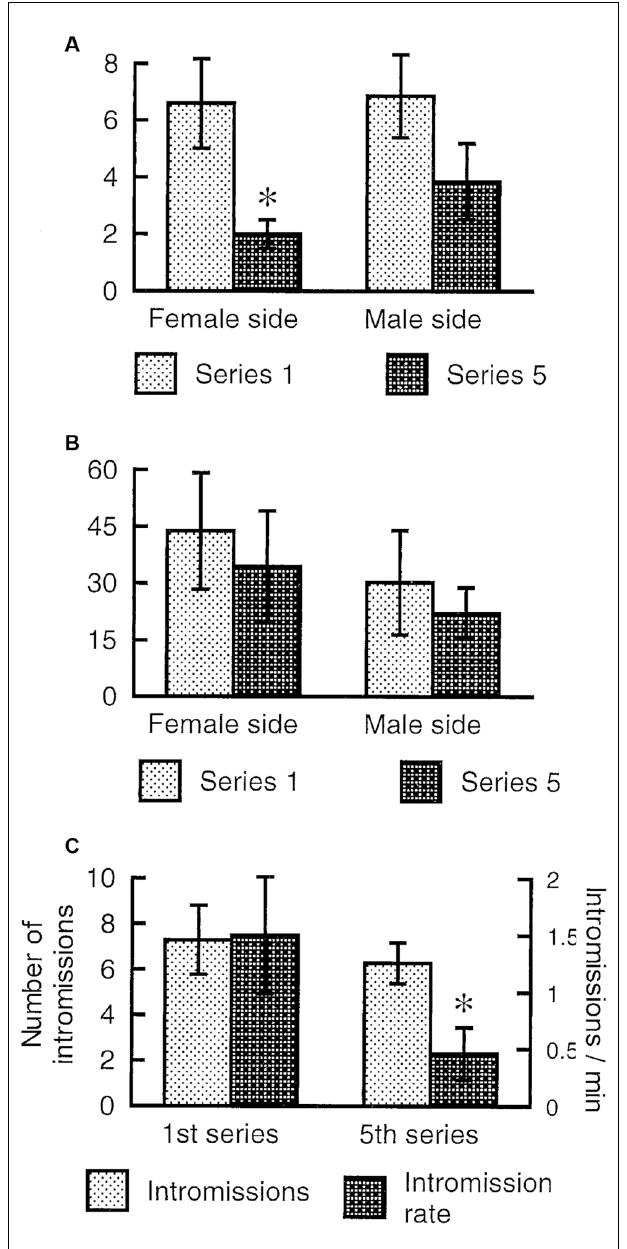
FIGURE 6 | Paracopulatory behaviors displayed by female rats tested in a divided cage until the male had achieved five ejaculations. We determined the number of those behaviors displayed in the male’s half as well as the number displayed in the female’s half during the 1st and 5th ejaculatory series. (A) The rate expressed as number per minute of paracopulatory behavior. Two-factor ANOVA with repeated measures on one factor (Series) revealed a main effect of Series ( F ( 1,6 ) = 20.269, p = 0.004) but not of Side (female, male; F ( 1,6 ) = 0.778, p = 0.412). The interaction Series × Side was also non-significant ( F ( 1,6 ) = 1.326, p = 0.293). (B) Number of behaviors. ANOVAs found no effect (all p s > 0.24). (C) Male copulatory behavior. The number of intromissions performed during the 1st and 5th series was similar ( t ( 6 ) = 0.786, p = 0.462, paired t -test). The rate of intromission, calculated as number per minute, was lower in the 5th series than in the 1st ( t ( 6 ) = 2.691, p = 0.018). Data (mean ± SEM) are from an experiment performed by Ellinor Ellingsen and Ana Lene Turi. ∗ Different from 1st series ( p <